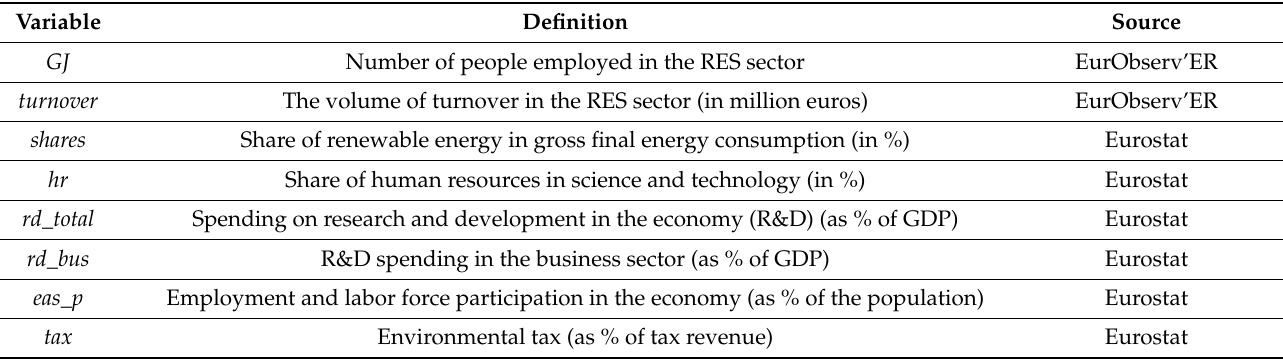
Table 1. Variable definitions and sources.